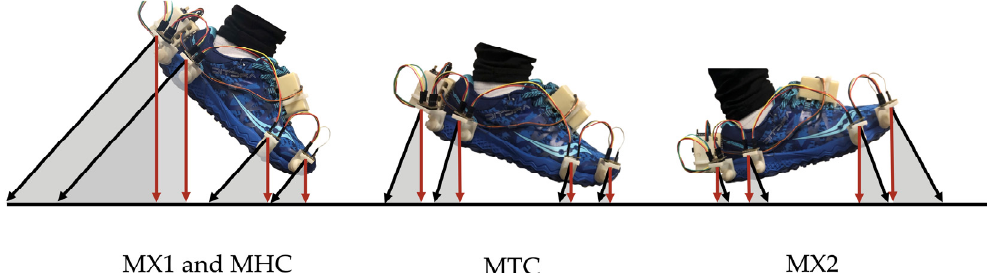
Figure 5. The foot angle at the different phases of the gait cycle. The black arrows represent the dis- tance measured by the ToF sensors. The red arrows represent the actual foot-to-ground distance. The sensors. The red arrows represent the actual foot-to-ground distance. The grey shaded regions represent the foot angle ( β grey shaded regions represent the foot angle ( 𝛽 ).